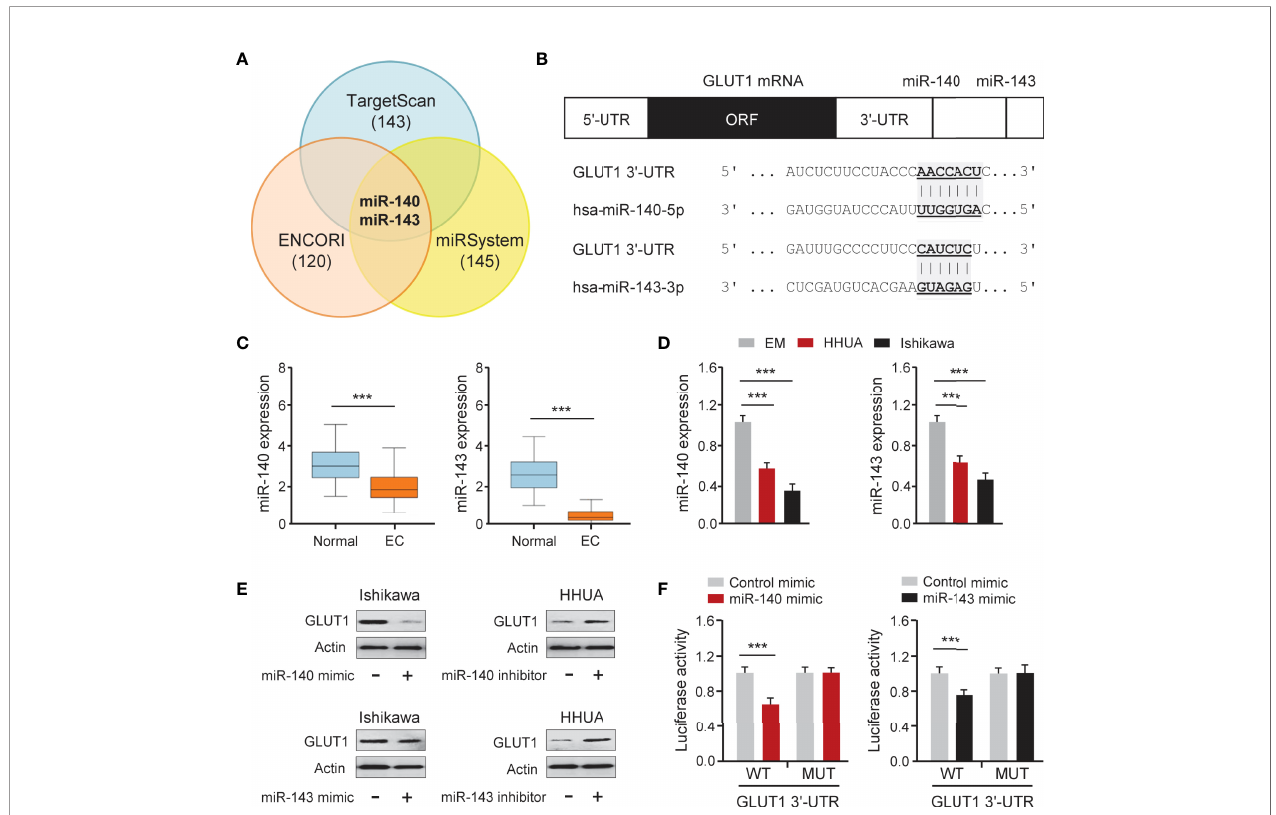
FIGURE 5 | GLUT1 is a Target Gene of MiR-140 and MiR-143. (A) Venn diagram showing the overlapping miRNAs predicted by three online databases. (B) Computational prediction of duplex formation between miR-140/miR-143 and the GLUT1 3 ′ -UTR region. (C) The expression of miR-140/miR-143 in TCGA EC tissues and normal tissues (miR-TV database). (D) qRT-PCR analysis of miR-140/miR-143 in EC and EM cells. (E) GLUT1 protein expression was examined using western blotting assays in EC cells transfected as indicated. (F) Luciferase reporter assays in Ishikawa cells transfected with the wild-type (WT) or mutant